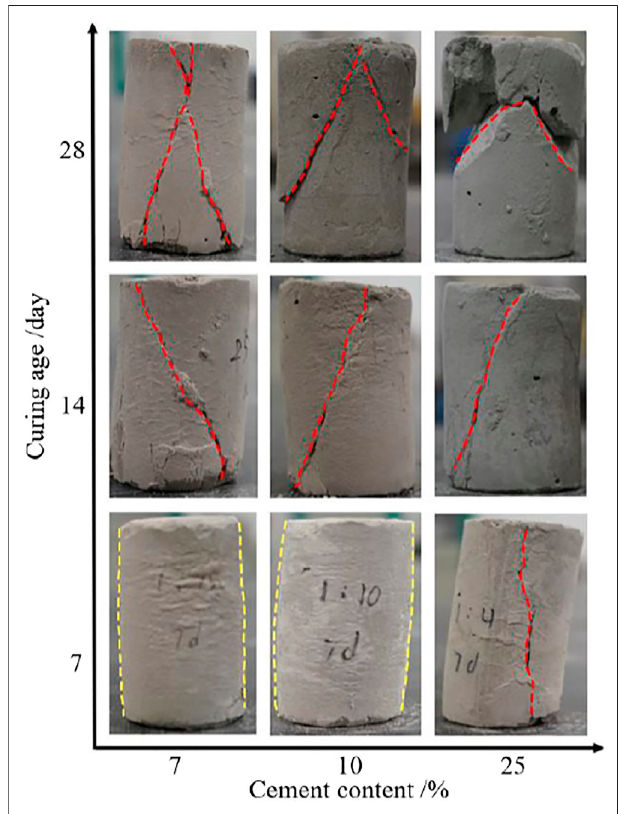
FIGURE 7 | CPB Failures under triaxial compression.